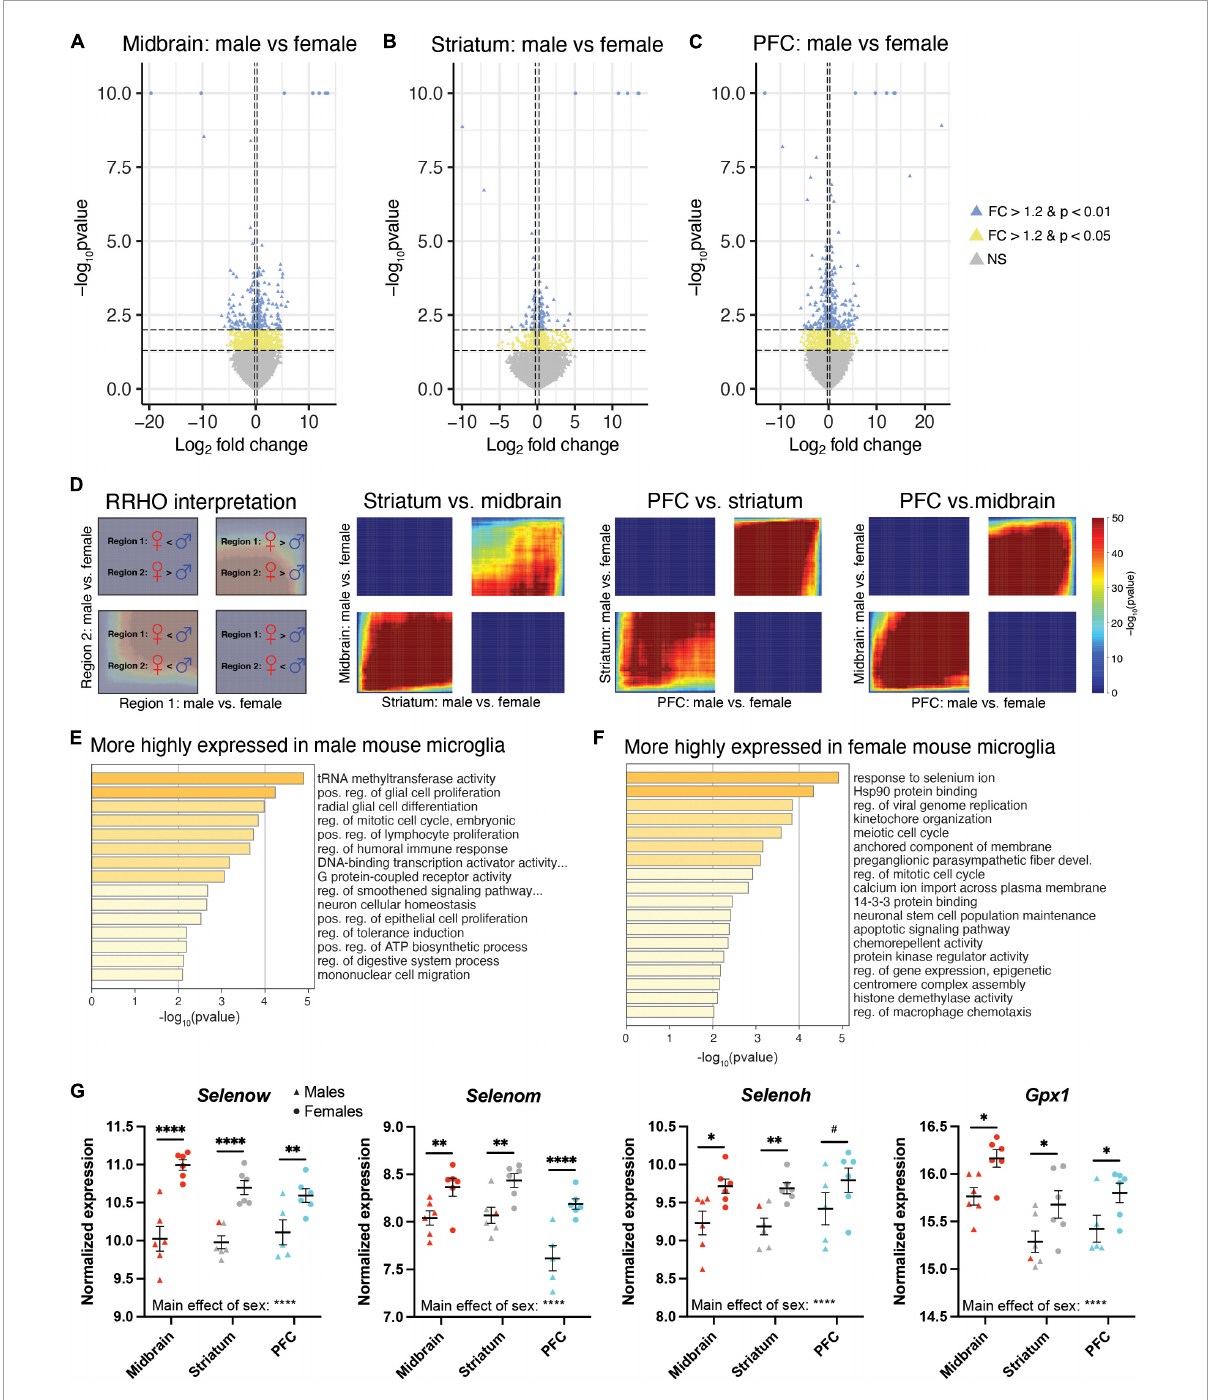
FIGURE6 Differential expression of microglia-specific transcripts between males and females. Log 2 FoldChange plotted relative to –log 10 pvalue by volcano plots for differentially expressed (DE) transcripts between males and females in the midbrain (MB; A ), striatum (B) , and prefrontal cortex (PFC; C ). Horizontal dashed lines represent p -value significance cutoffs of p < 0.01 and p < 0.05, while vertical dashed lines represent log 2 FC cutoffs of ≤ –0.26 or ≥ 0.26 (FC ≥ 1.2). Blue triangles represent DE transcripts with p < 0.01 and FC ≥ 1.2. Yellow triangles represent DE transcripts with p < 0.05 and FC ≥ 1.2. (D) Rank rank hypergeometric overlap (RRHO) plots indicating high degree of overlap of DE transcripts between males and females across brain regions. The interpretation of RRHO plots is indicated on the left, followed by RRHO plots representing 2 brain region comparisons. Enrichment in the bottom left and top right quadrants indicates consistent sex differences across regions. (E) Top pathways associated with transcripts more highly expressed in male microglia. (F) Top pathways associated with transcripts more highly expressed in female microglia. (G) The selenium-related transcripts, Selenow , Selenom , Selenoh , and Gpx1 were all more highly expressed in female microglia across all three brain regions. ∗ , p < 0.05; ∗∗ , p < 0.01; ∗∗∗∗ , p < 0.0001; # , p <